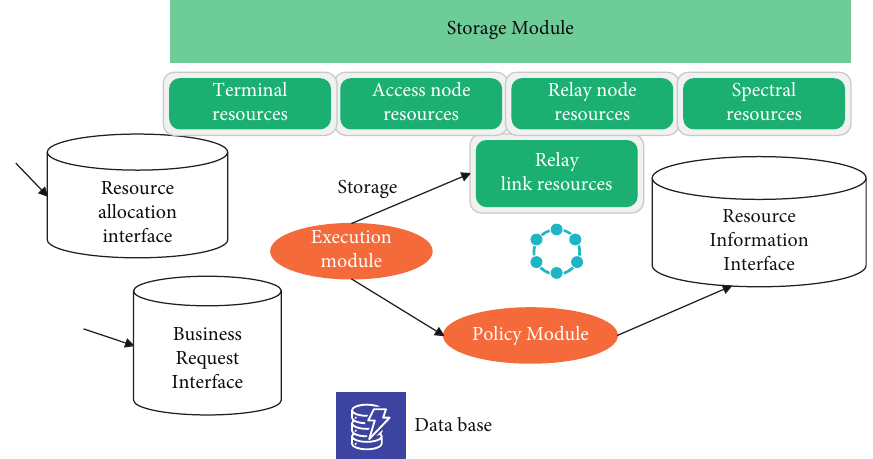
Figure 4: Schematic diagram of the